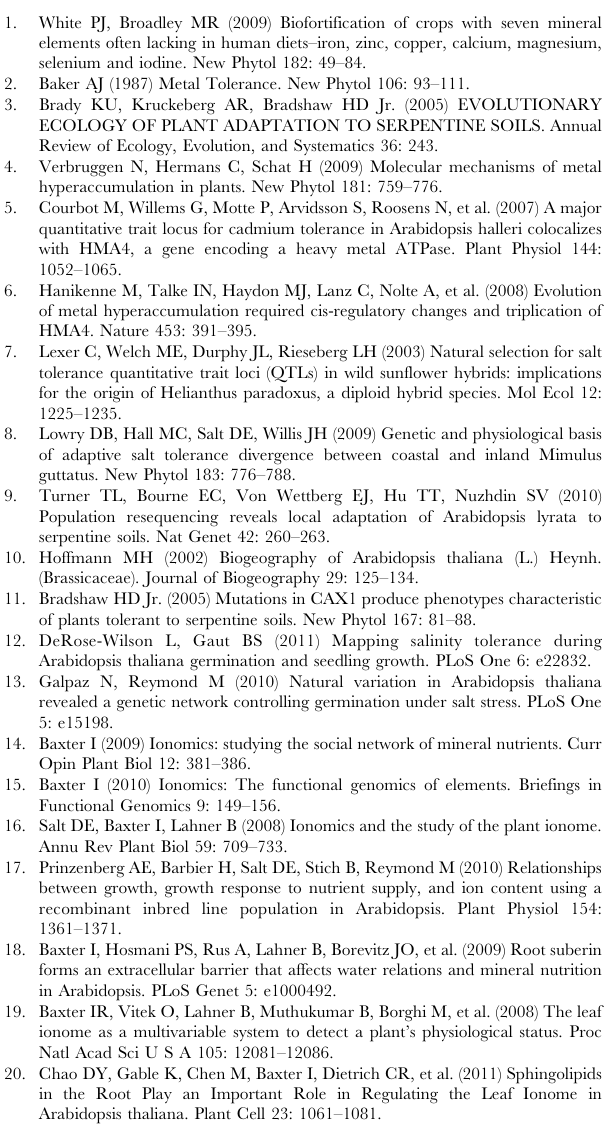
Figure S2 Plot of control line averages for each tray before normalization for Soil Leaf 1 experiment. All non- control lines are averaged into the ‘‘Other’’ line. (PDF) Figure S3 Plot of control line averages for each tray after normalization for Soil Leaf 1 experiment. All non- control lines are averaged into the ‘‘Other’’ line. (PDF) Figure S4 Plot of control line averages for each tray before normalization for Soil Leaf 2 experiment. All non- control lines are averaged into the ‘‘Other’’ line. (PDF) Figure S5 Plot of control line averages for each tray after normalization for Soil Leaf 2 experiment. All non- control lines are averaged into the ‘‘Other’’ line. (PDF)